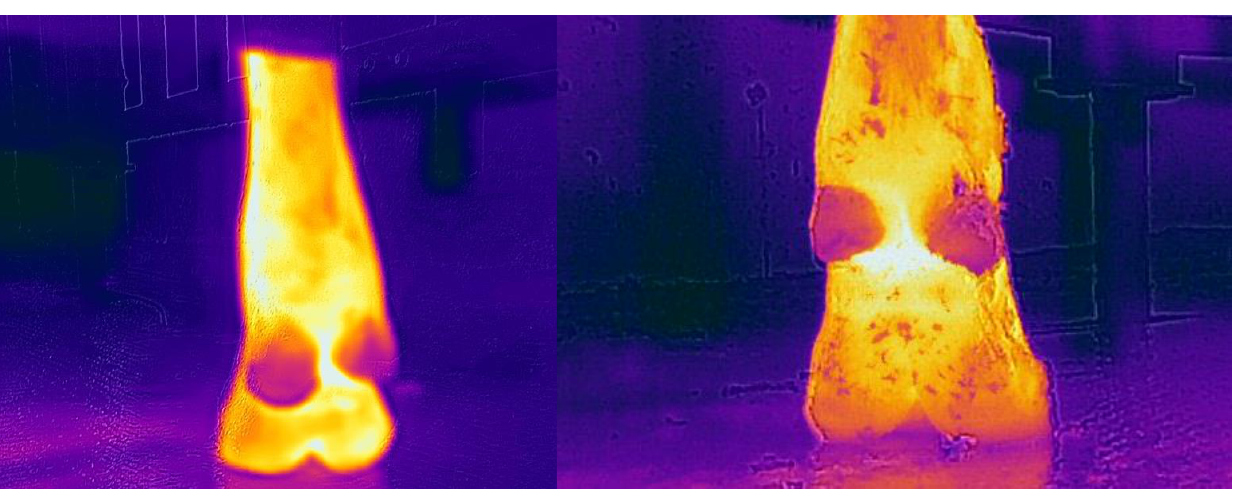
Figure 1. ( Left ) A thermogram captured by the CAT s62 Pro Smartphone of the target area of imaging for all images taken in this study. The target area assessed is the point of hottest temperature present below the heel bulbs; this thermogram was cropped from a portrait image. ( Right ) A thermogram target area assessed is the point of hottest temperature present below the heel bulbs.